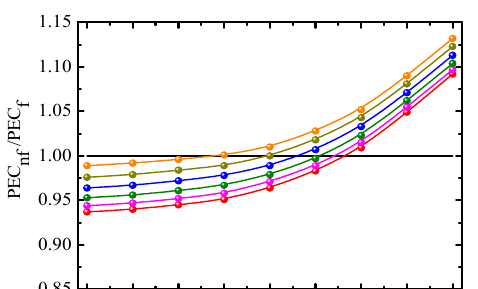
Figure 13. PEC nf /PEC f vs. Weissenberg number for different viscosity ratios ( Φ = 1.0%, Re = 2.5, α = 0.2). — • —: β 0 = 1.0; — • —: β 0 = 0.9; — • —: β 0 = 0.3; — • —: β 0 = 0.2; — • —: β 0 = 0.1; and — • —: β 0 = 0.